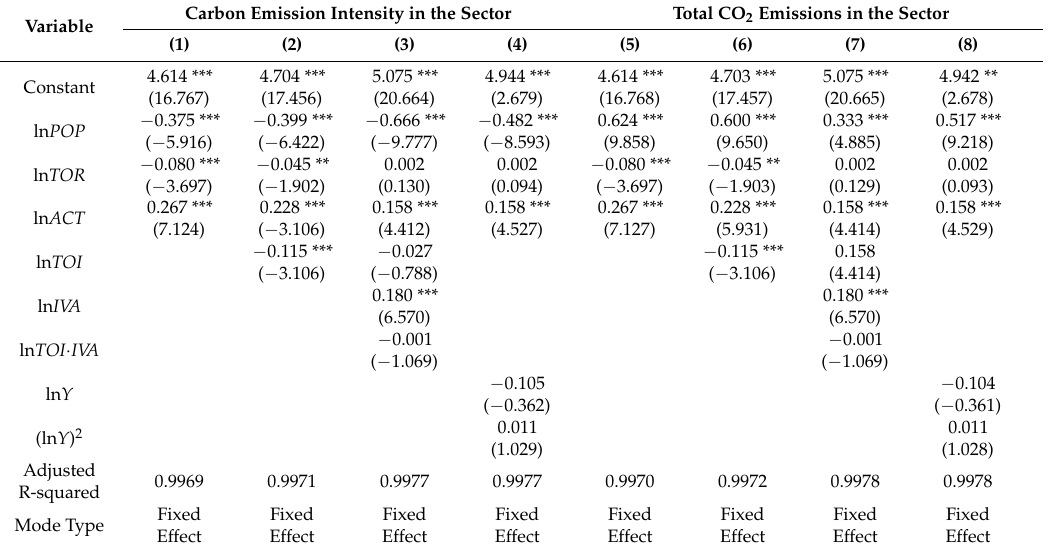
Table 2. Results of regression for all